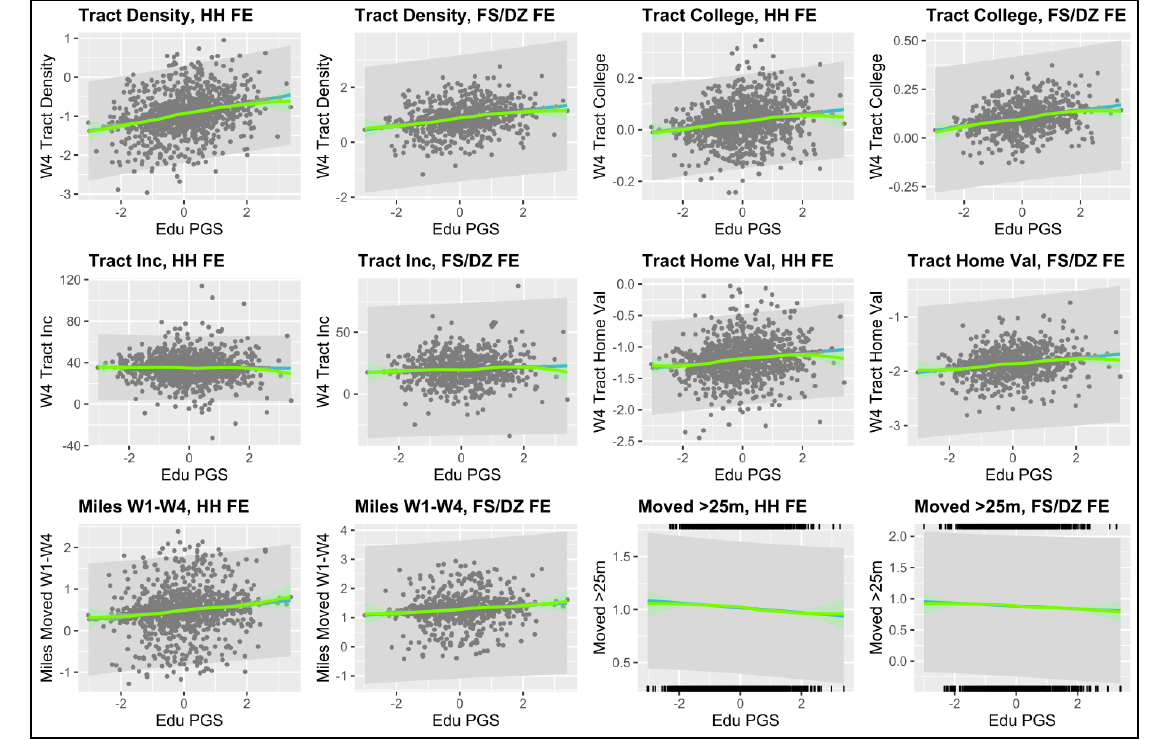
Figure 4: Visualized regression lines for individual education PGS predicting neighborhood conditions in wave 4 and distance traveled between waves (W)1 and 4 in household (HH) and full sibling/dizygotic twin (FS/DZ) fixed-effects (FE) models. Regression lines (blue for linear, green using Loess smoothing) are consistent with the estimates contained in Tables 3 and 4 and produced using the visreg package in R (see Breheny and Burchett